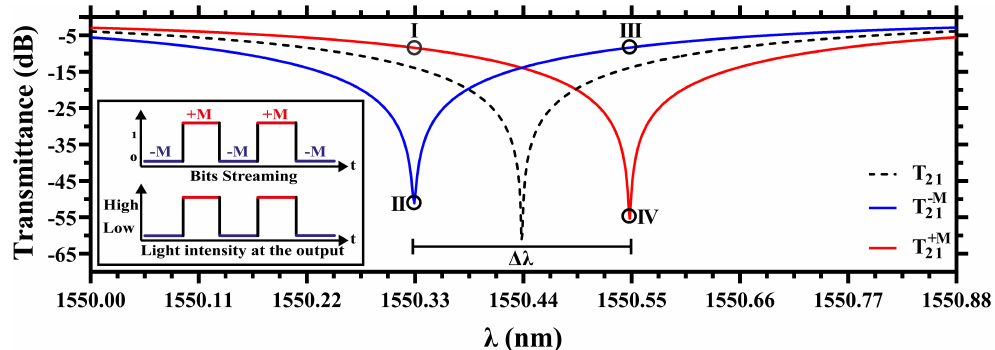
Figure 2. Transmittances in the MO-MRR for non-magnetized (black dashed curve) and magnetized to − M (blue solid curve) and + M (red solid curve). The points I and III symbolize a possible coding for bit 1, whilst the points II and IV may coding the bit 0, as depicted in the